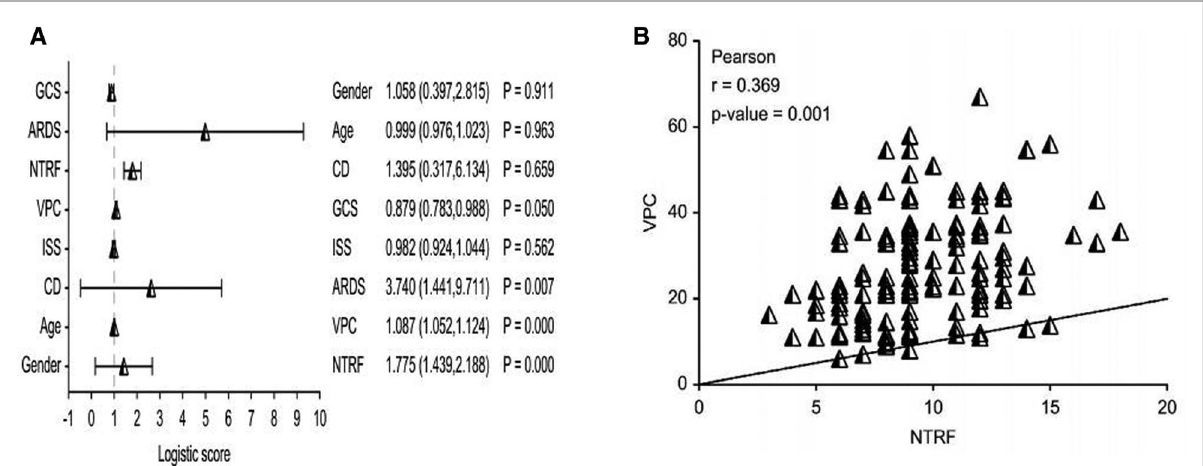
FIGURE 4 Results of the multivariate logistic regression analysis of the patients ( A ). The correlation analysis results of the volume of pulmonary contusion and the total number of fractures of the ribs ( B ). CD, cardiovascular diseases; GCS, Glasgow coma score; ISS, injury severity score; ARDS, acute respiratory distress syndrome; VPC, volume of pulmonary contusion; NTRF, number of total rib